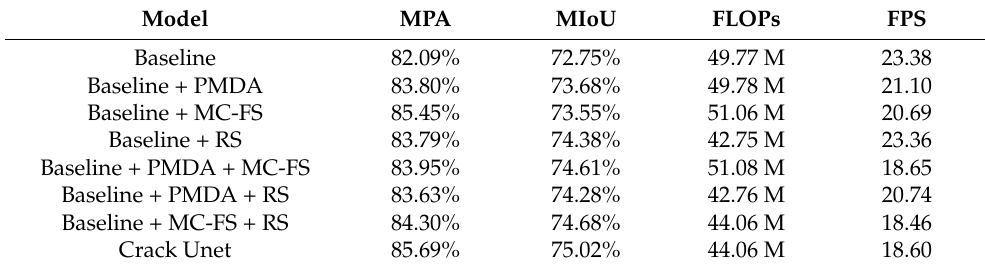
Table 5. Comparison of ablation experiment results.